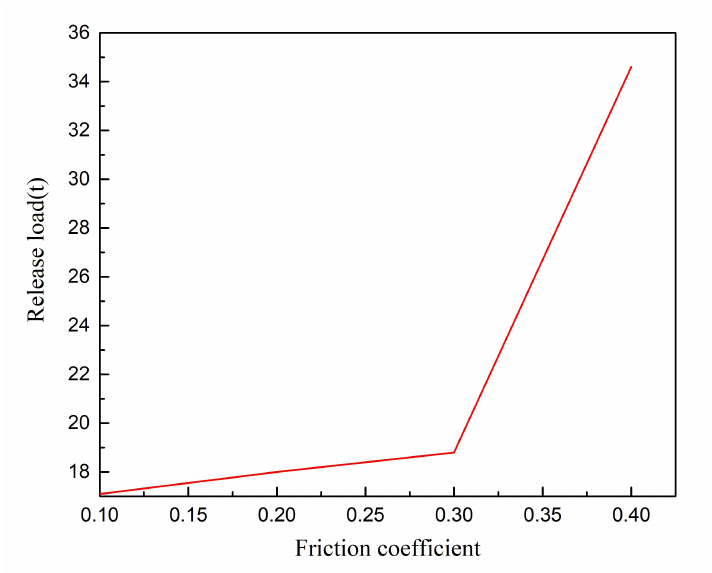
Figure 11. Variation curve of released load with friction